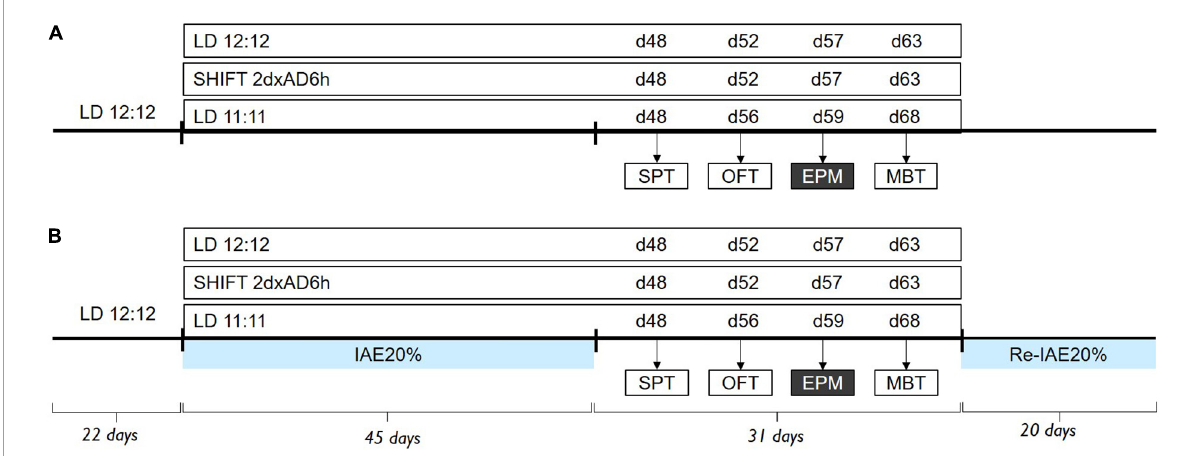
FIGURE1 Experimental design. Timeline of alcohol exposure and behavioral assessment (A) under LD24 ( n = 12), SHIFT ( n = 6), LD22 ( n = 4) conditions, and (B) with access to intermittent alcohol exposure (LD24 n = 12, SHIFT n = 12, LD22 n = 12). Behavior tests were conducted during the light phase (ZT2), except for the EPM (ZT14). Zeitgeber (ZT) indicates hours after the onset of the light